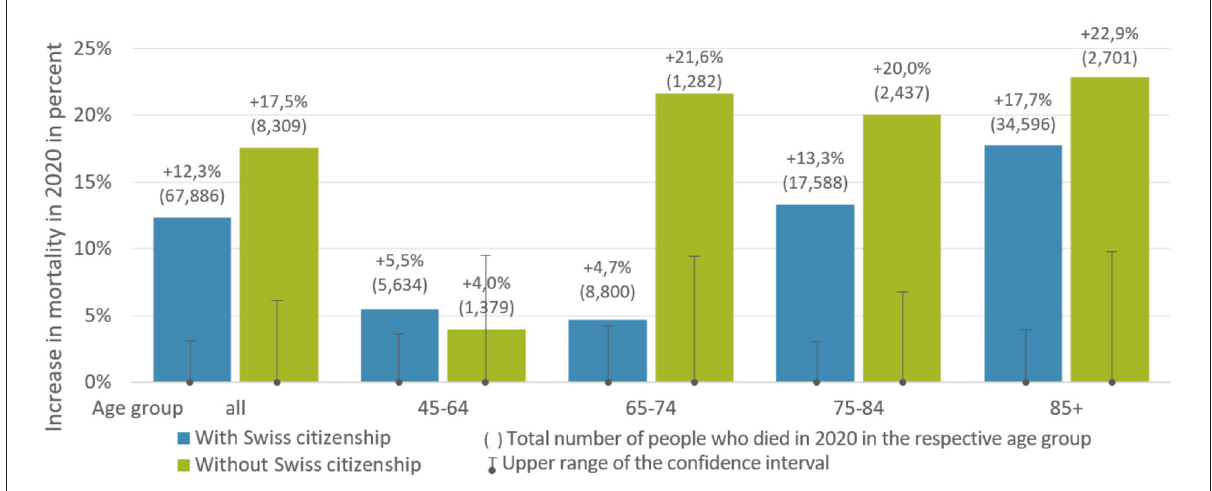
FIGURE3 Citizenship and age group-specific increase in mortality in 2020 relative to the mortality expected for 2020 based on the extrapolation of a respective group-specific linear trend over the years 2015–2019. Data source: Death statistics of the Swiss Federal Statistical Office (18).